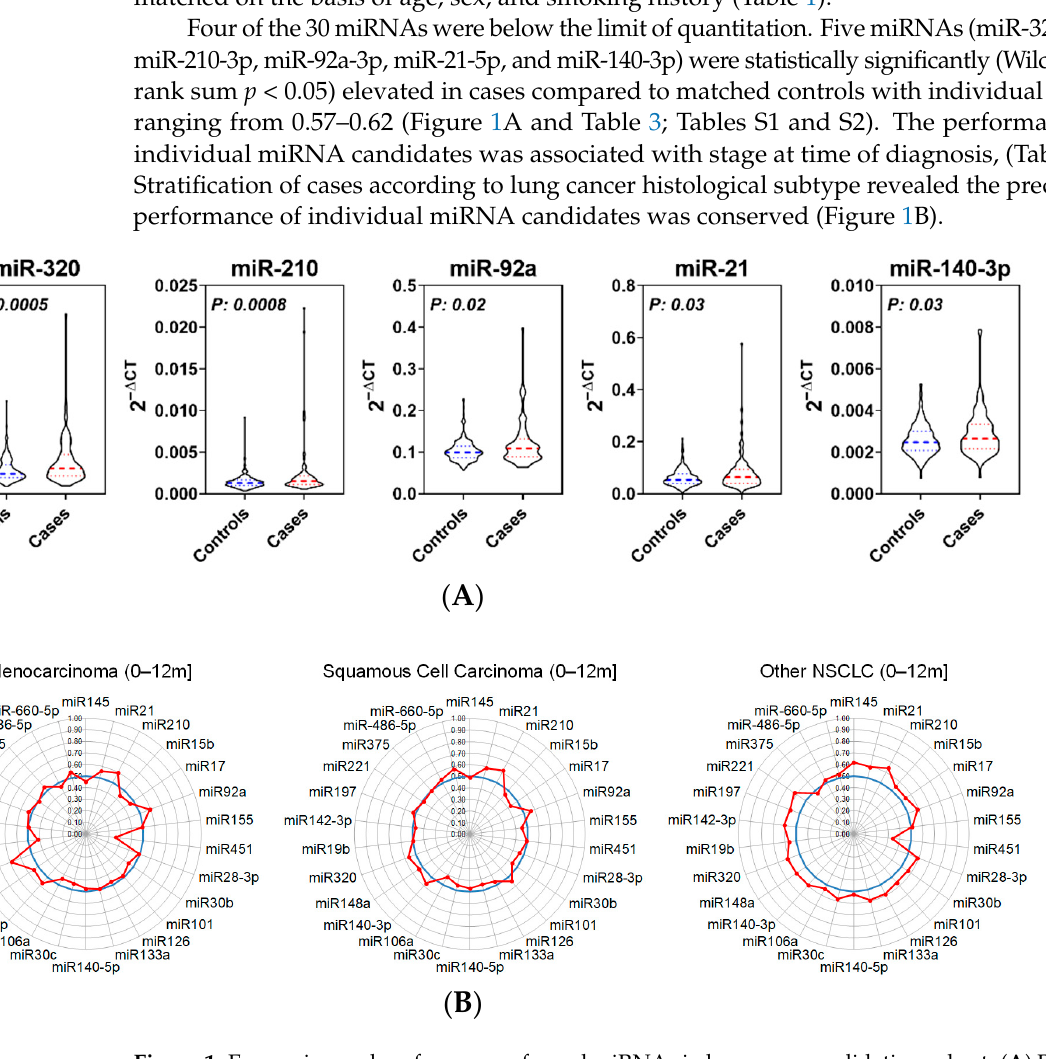
Figure 1. Expression and performance of panel miRNAs in lung cancer validation cohort. ( A ) Relative expression of top-performing upregulated miRNAs in prediagnostic lung cancer case sera ( N = 102) and matched controls ( N = 212). ( B ) Radar charts indicating predictive performance of panel miRNAs stratified according to lung cancer subtype. NSCLC, Non-Small-Cell Lung Carcinoma.